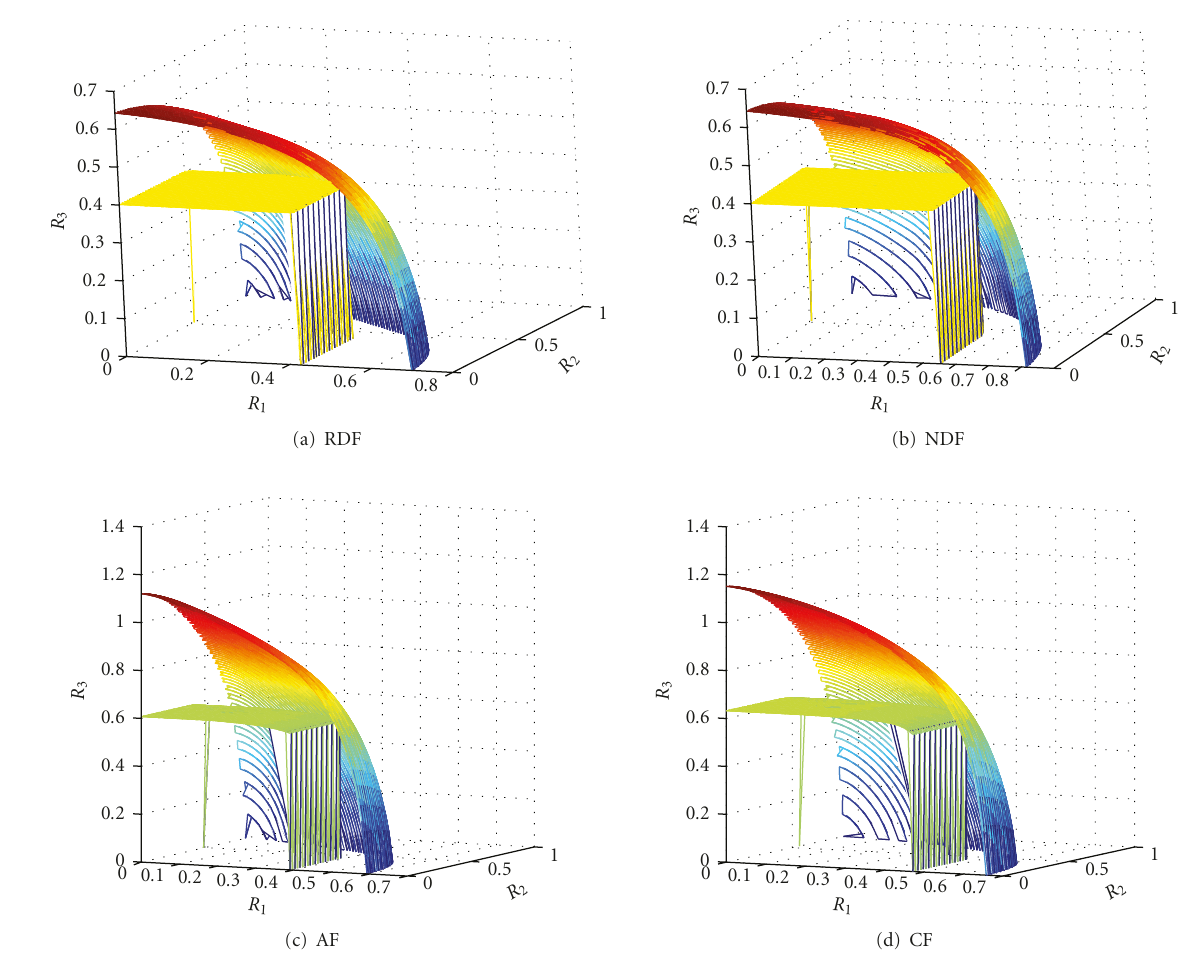
Figure 11: The achievable rate regions obtained by jointly optimal power and resource allocation and those obtained by power allocation alone with equal resource allocation for three-user system with | K 3 R | = 0 . 6, | K 30 | = 0 . 9, P 3 = 2, and the remaining parameters from Scenario 2 in Table